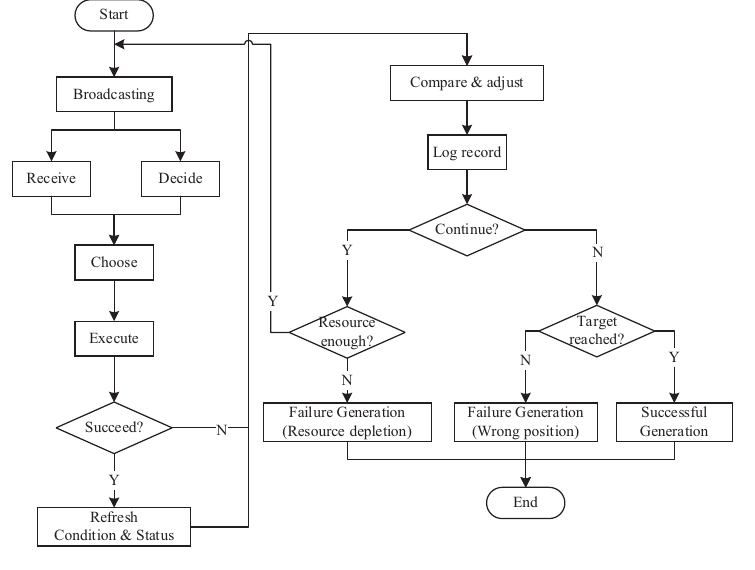
Figure 8. one primitive unit ’